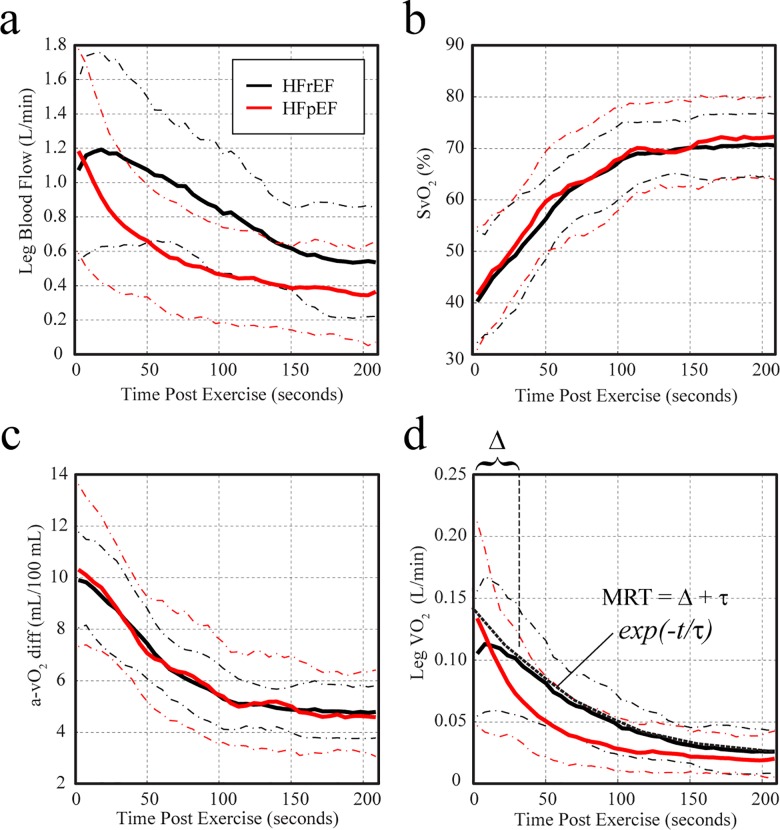
Group average recovery kinetics for blood flow and oxygen extraction and consumption.Average time course data for femoral vein blood flow (a), femoral venous oxygen saturation (b), a-v O2 diff (c) and muscle VO2 (d) are shown for HFrEF (black) and HFpEF (red) groups. The dashed lines show one standard deviation around the mean. The mean response time (MRT) for each curve is defined as the sum of the best-fit exponential recovery plus the delay to the onset of exponential recovery.